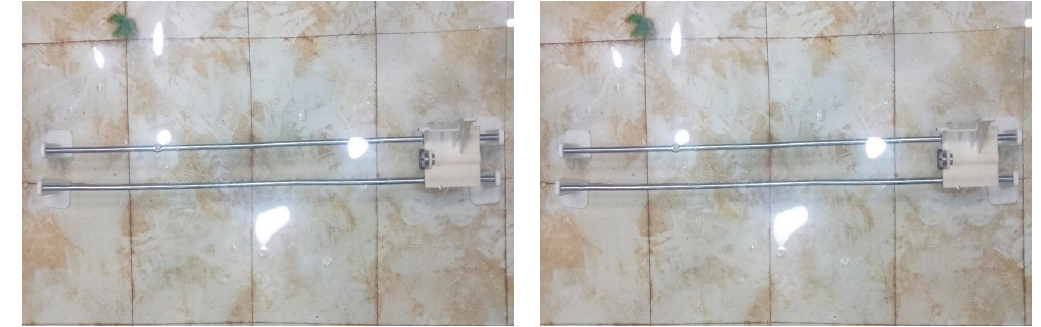
Figure 8. Linear moving device.